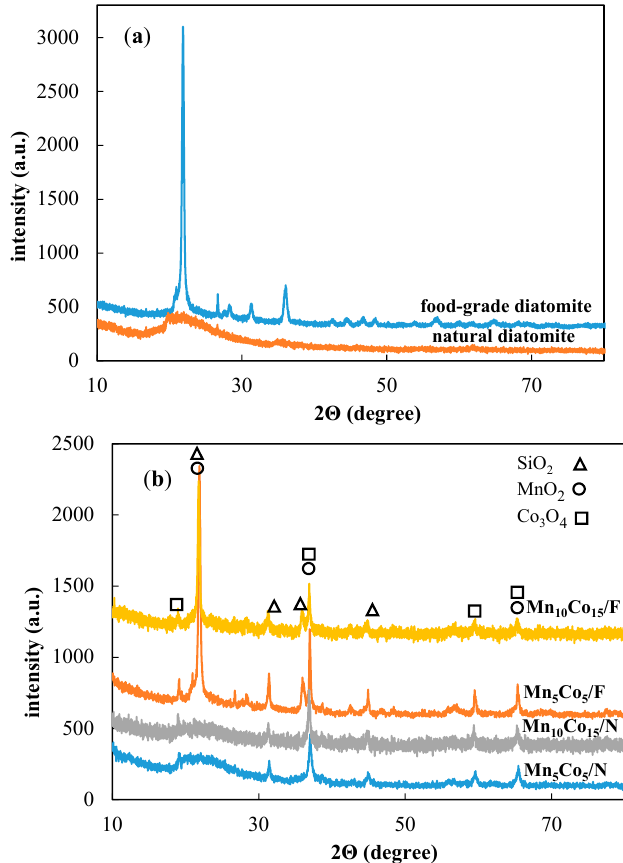
Figure 1. XRD patterns of ( a ) raw supports; ( b ) representative samples calcined at 250 °C.